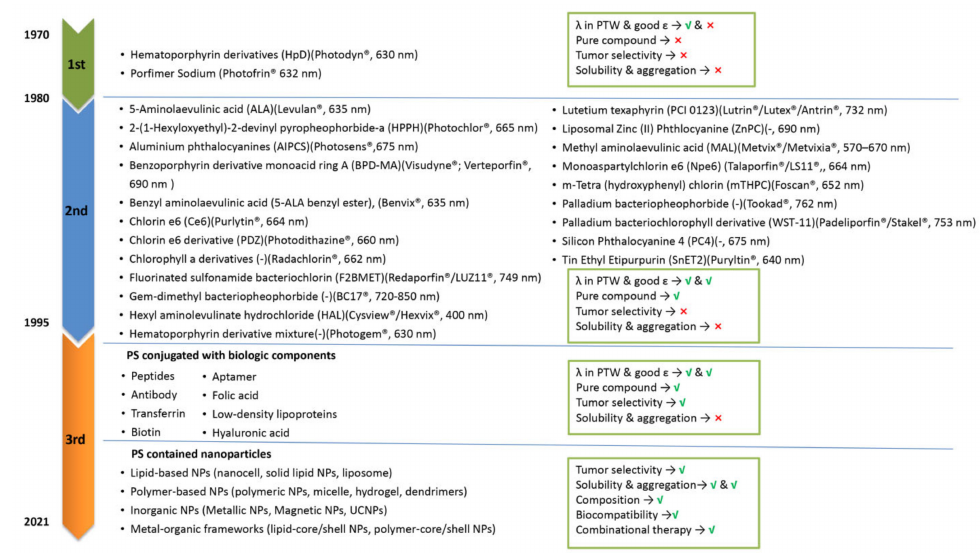
Figure 2. Different generations of PSs widely used in various cancer cell types. Currently developed PSs can be divided into first-generation PSs, second-generation PSs, and third-generation PSs. The description is provided as follows: • chemical name (abbreviation)(trade name is indicated with ® , and excitation wavelength is indicated in “nm“ during clinical PDT procedure). If information is not available, this is indicated with (-). λ in PTW represents the typical wavelength at which absorption of photosensitizer occurs to penetrate into tissues (PTW, λ > 600 nm), and ε represents the absorption rate at